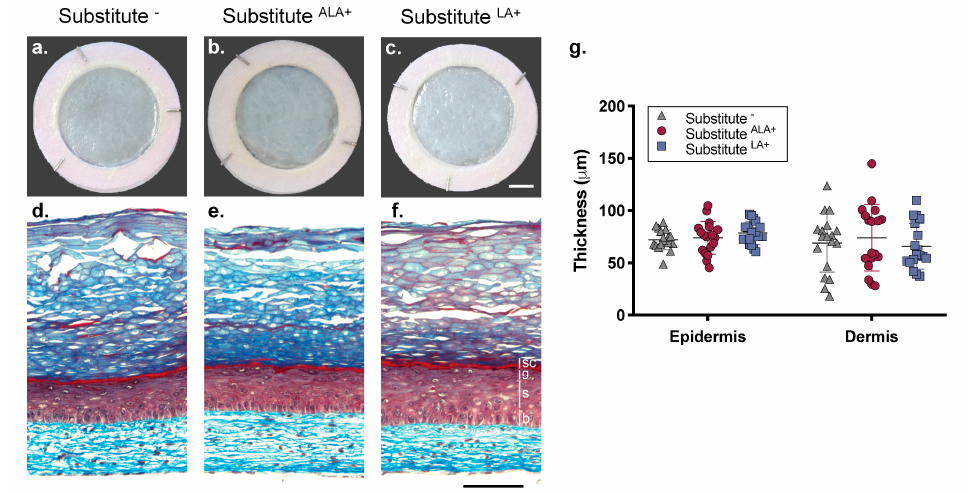
Figure 1. Impact of EFA supplementation on skin substitute cutaneous morphology. ( a–c ) Macroscopic aspect and ( d – f ) histological cross-section after Masson’s trichrome staining of the skin substitutes. Vertical bars indicate epidermal layers. b: basal layer, s: spinous layer, g: granular layer and sc: compact layers of the stratum corneum. Scale bars: (a–c) 1 cm, (d–f) 100 μ m. ( g ) Epidermal and dermal thickness quantified from Masson’s trichrome staining. N = 18 (3 donors, 2 skin substitutes per donor, 3 measurements per skin substitute). One-way ANOVA followed by Tukey’s post-hoc test. P < 0.05 was considered statistically significant.